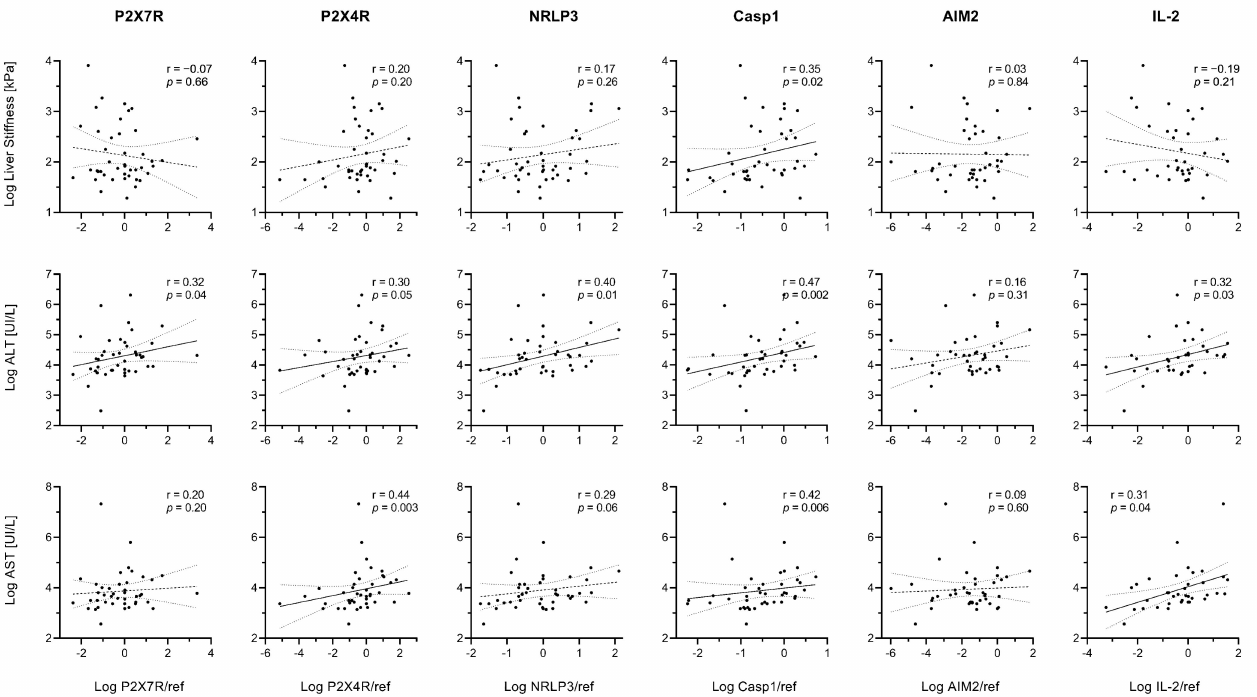
Figure 8. Relationships between gene expression and markers of disease severity. Spearman’s rank correlation coefficients (r) and p values ( p ) are reported. Data were log-transformed for graphical purposes. Best-fit lines of log-transformed data are shown as continuous lines ( p < 0.05) or dashed lines ( p ≥ 0.05) along with their 95% confidence bands (dotted